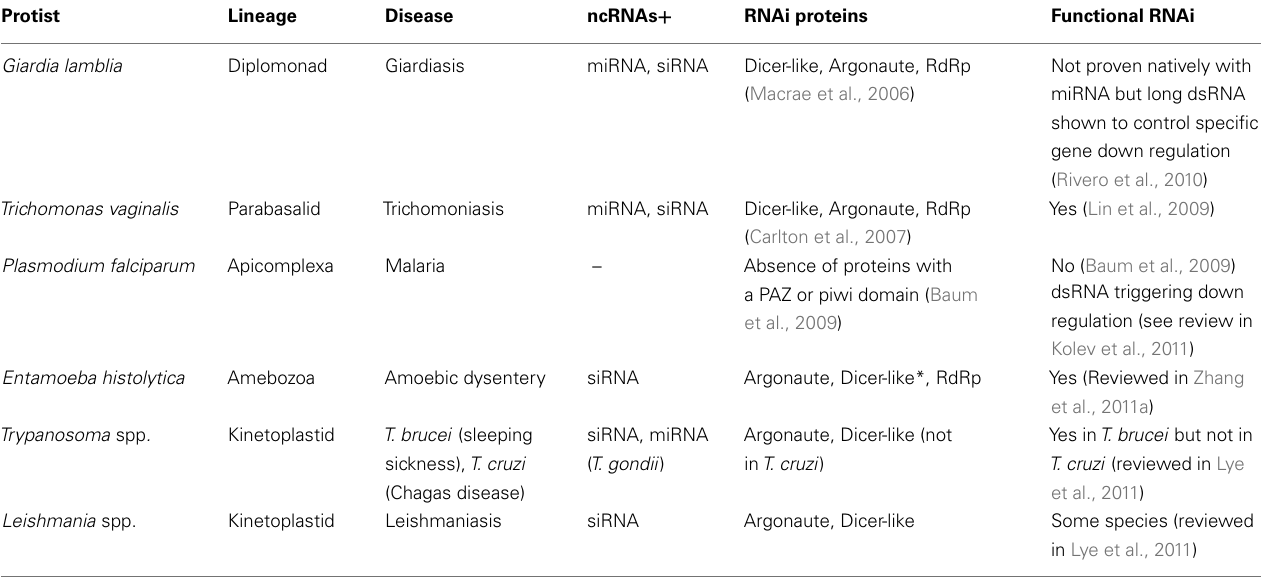
Table 1 | Summary of ncRNA discovery in human pathogenic